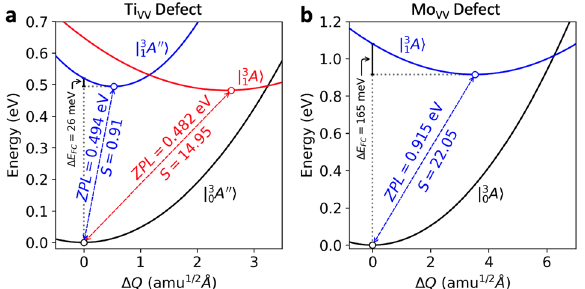
Fig. 5 Con fi guration coordinate diagrams. Con fi guration diagram of the a Ti VV defect and b Mo VV defect in h -BN. The potential energy surfaces for each state are as follows: the triplet ground state in black, triplet excited state in blue, and for the Ti VV defect the pseudo-Jahn – Teller triplet excited state in red. The zero-phonon lines (ZPL) are given as the energetic separation between the minima of the respective potential energy surfaces, along with the corresponding Huang – Rhys factors ( S ). The dashed black line represents the vertical excitation energy between triplet ground and excited states, and Δ E FC represents relaxation energy to equilibrium geometry at the excited state.